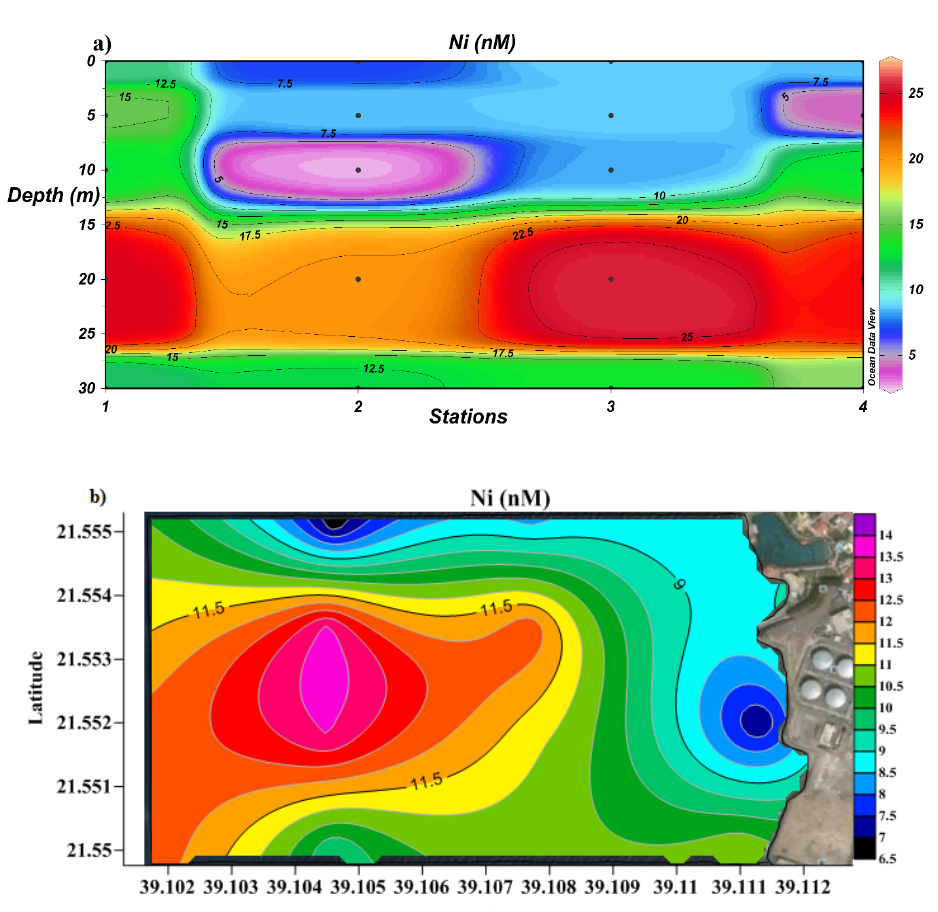
Figure 7: Cross-section profile (a) and surface distribution (b)of dissolved Ni.